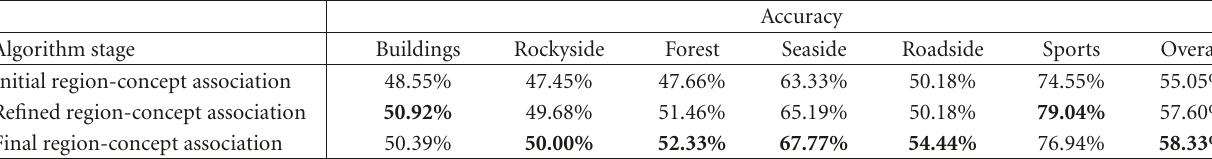
Table 4: Concept detection accuracy.